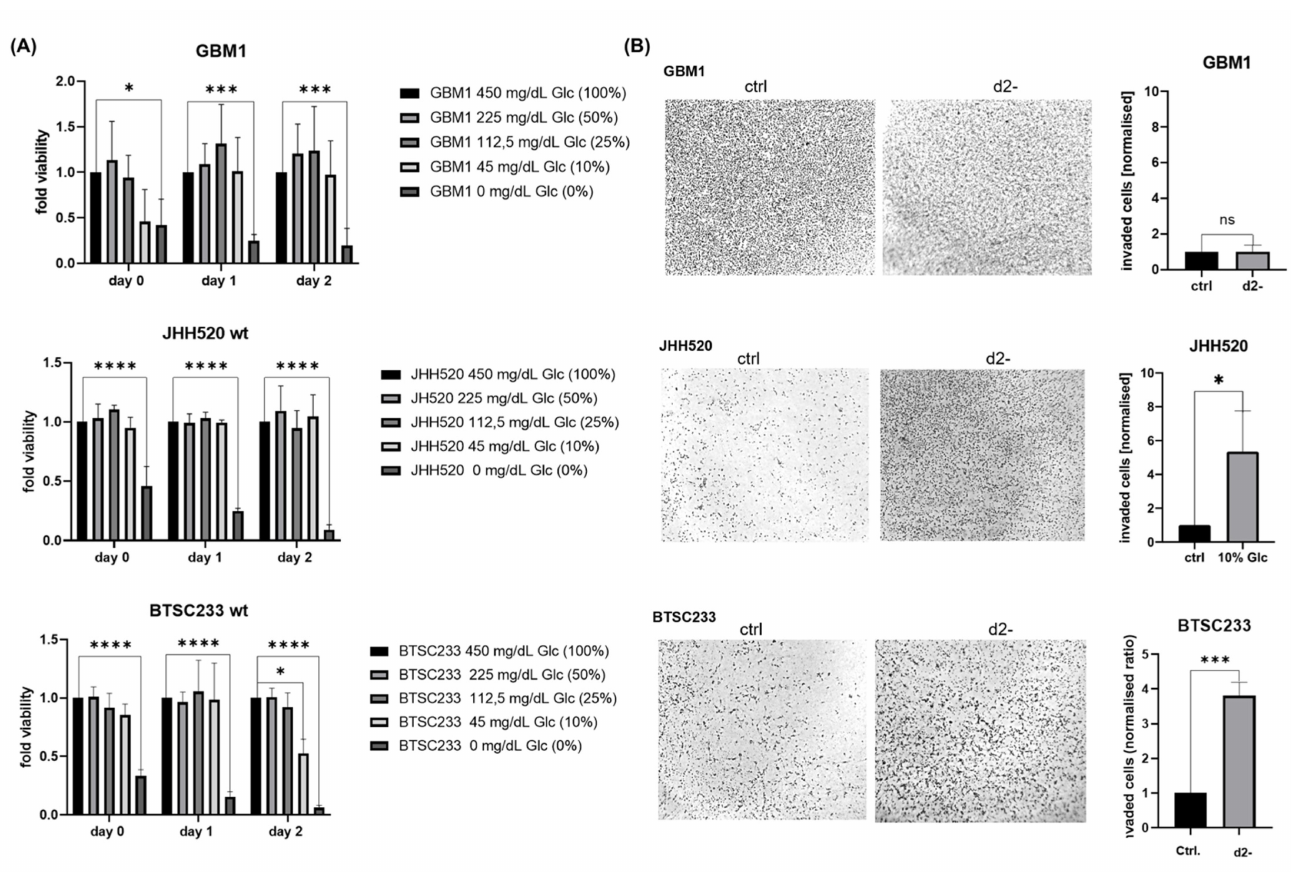
Figure 1. Glucose starvation decreases cell viability and enhances invasion in glioblastoma cell lines. ( A ) Glioblastoma cell lines (GBM1, JHH520, and BTSC233) were cultivated in standard cell culture glucose concentrations (450 mg/dL), decreased glucose concentrations (225 mg/dL, 112, 5 mg/dL, and 45 mg/dL) and in a glucose-depleted cell culture medium. The glucose concentration reduced to 45 mg/dL significantly decreased cell viability ( p < 0.05) in BTSC233, whereas glucose depletion significantly inhibited viability in all cell lines ( p < 0.0001). ( B ) A Boyden chamber assay was performed with all cell lines (GBM1, JHH520, and BTSC233) cultivated in standard (450 mg/dL) as a control condition (ctrl) and were compared to the corresponding starved samples (0 mg/dL) for 48 h (d2-). Glucose deprivation significantly enhanced invasion in JHH520 ( p < 0.05) and BTSC233 cells ( p < 0.001). The data are represented as mean + SD ( n = 3). Statistical significance was